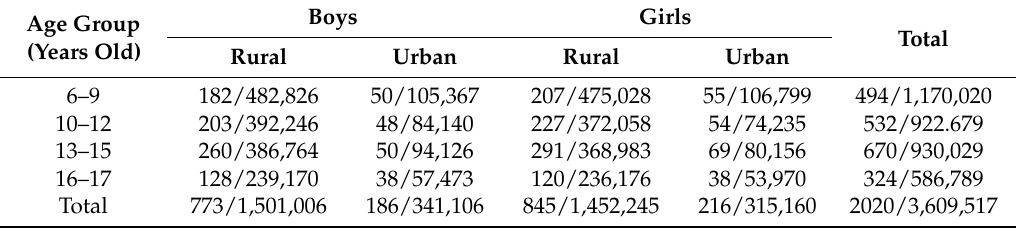
Table 1. Number of children who participated in the study by age group, sex, and area of